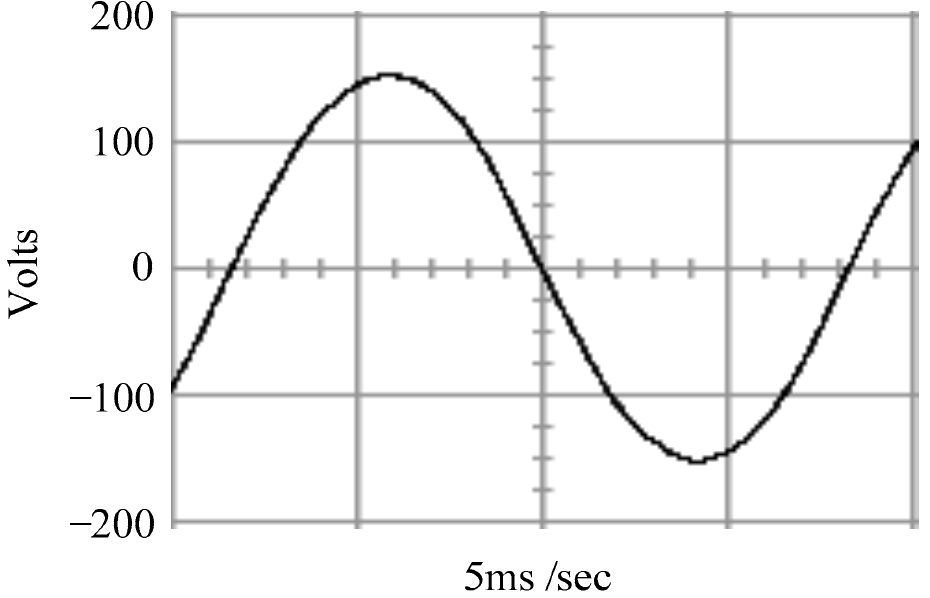
Figure 14. Experimental output voltage with the proposed technique under LC parametric varia- tions). Table 2. Simulated and experimental voltage droop and %THD.